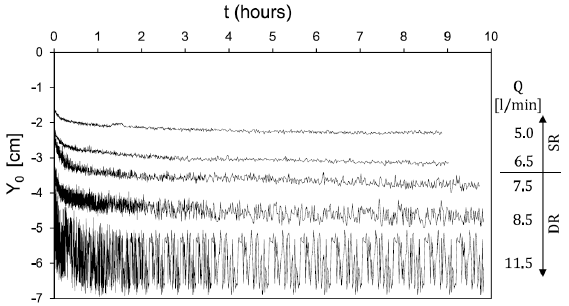
Figure 3: Time evolution of the maximum depth Y 0 for di ff erent flow rate Q and b 0 = 1 cm , SR is the steady regime and DR is the digging-refilling regime (Martino et al. , 2019). Figure 4: Measured experimental water velocity profile in comparison with the numerical velocity profiles for Q = 11 . 5 l / min in 2D and 3D.